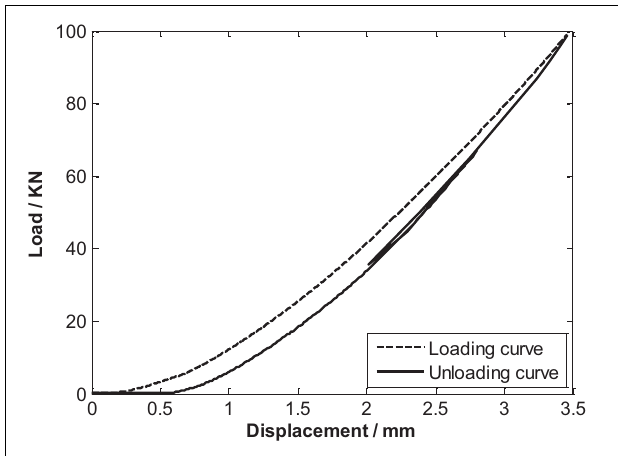
FIGURE 3 | Loading–unloading curve of load system.